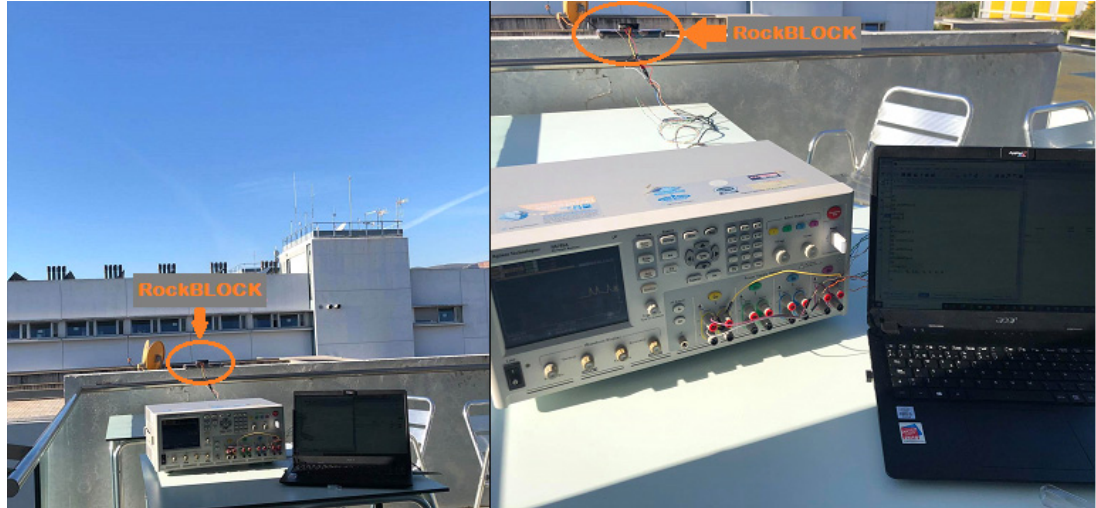
Figure 3. Outdoor scenario used for the current consumption measurements of the RockBLOCK Mk2 Iridium IoT device.